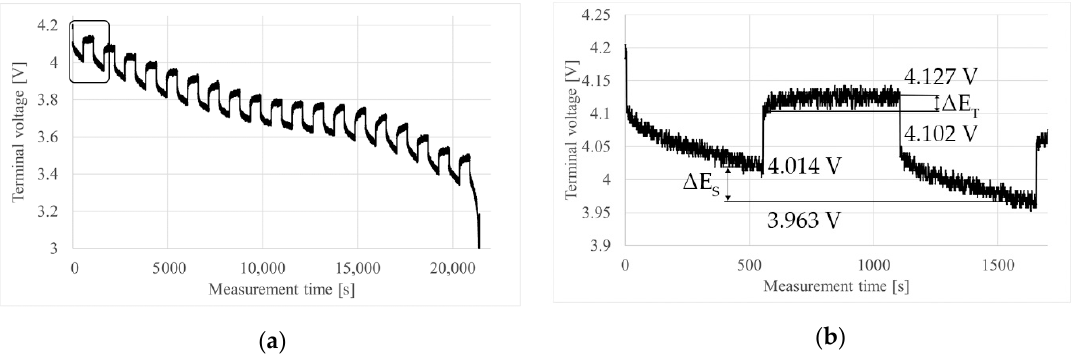
Figure 7. GITT measurements on the inspected cell applying a load current of 0.3 C at room temperature. ( a ) GITT cycles until a complete discharge ( b ) Detailed evaluation of GITT for the first cycle highlighted by the rechtange in (a).